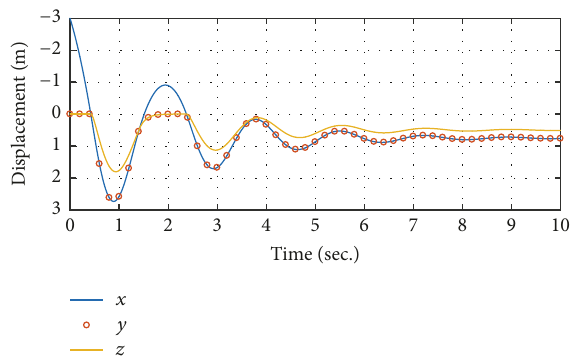
Figure 9: Time history of displacements in viscoelastic system shown in Figure 1.